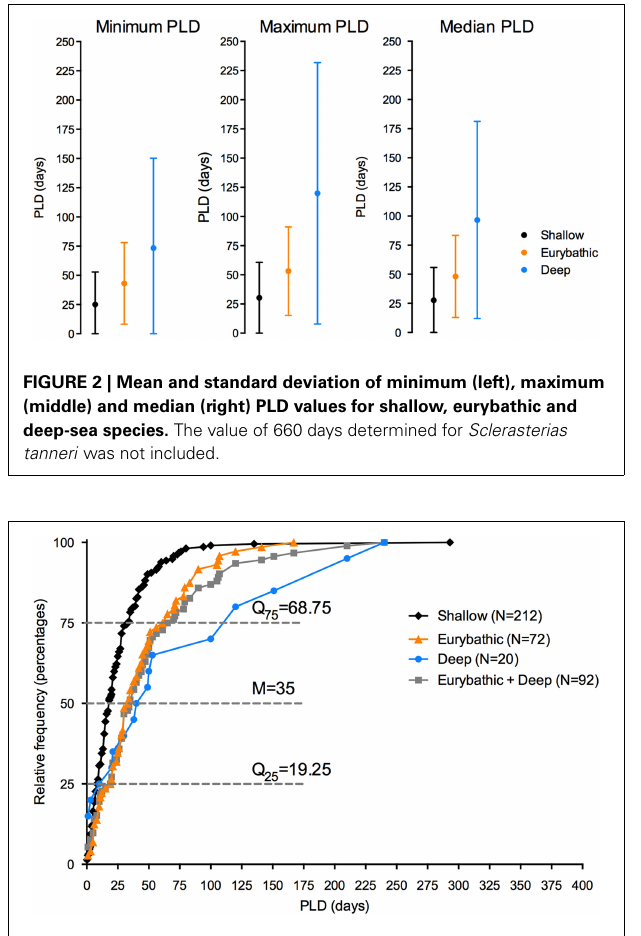
FIGURE 3 | Histogram of frequency of minimum PLD estimates available for shallow, eurybathic and deep-sea species. Median, percentile 25 and 75 are shown for PLD values of eurybathic and deep-sea species pooled together. The value of 660 days determined for Sclerasterias tanneri was not